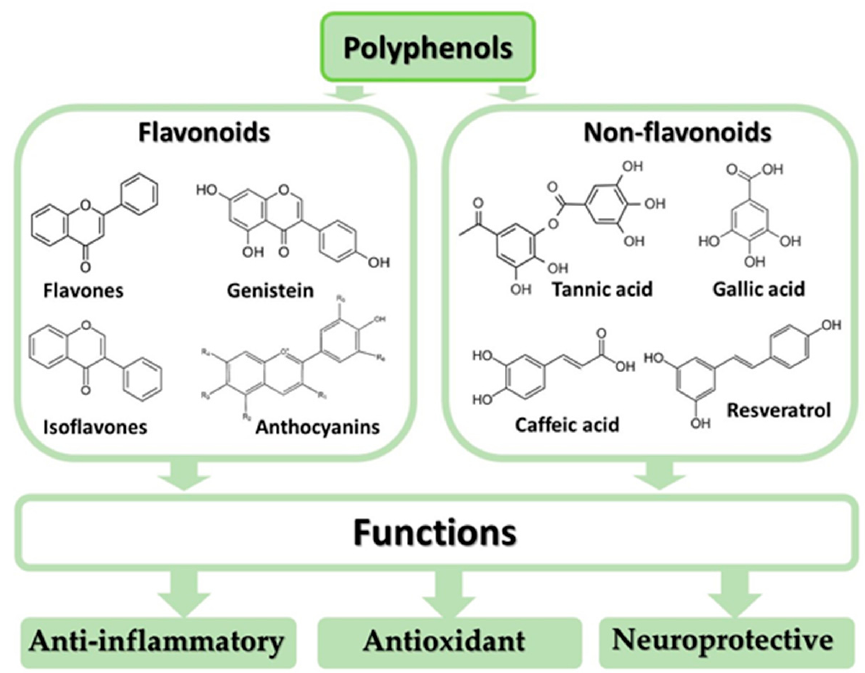
Figure 1. Classification and health benefits of polyphenols.